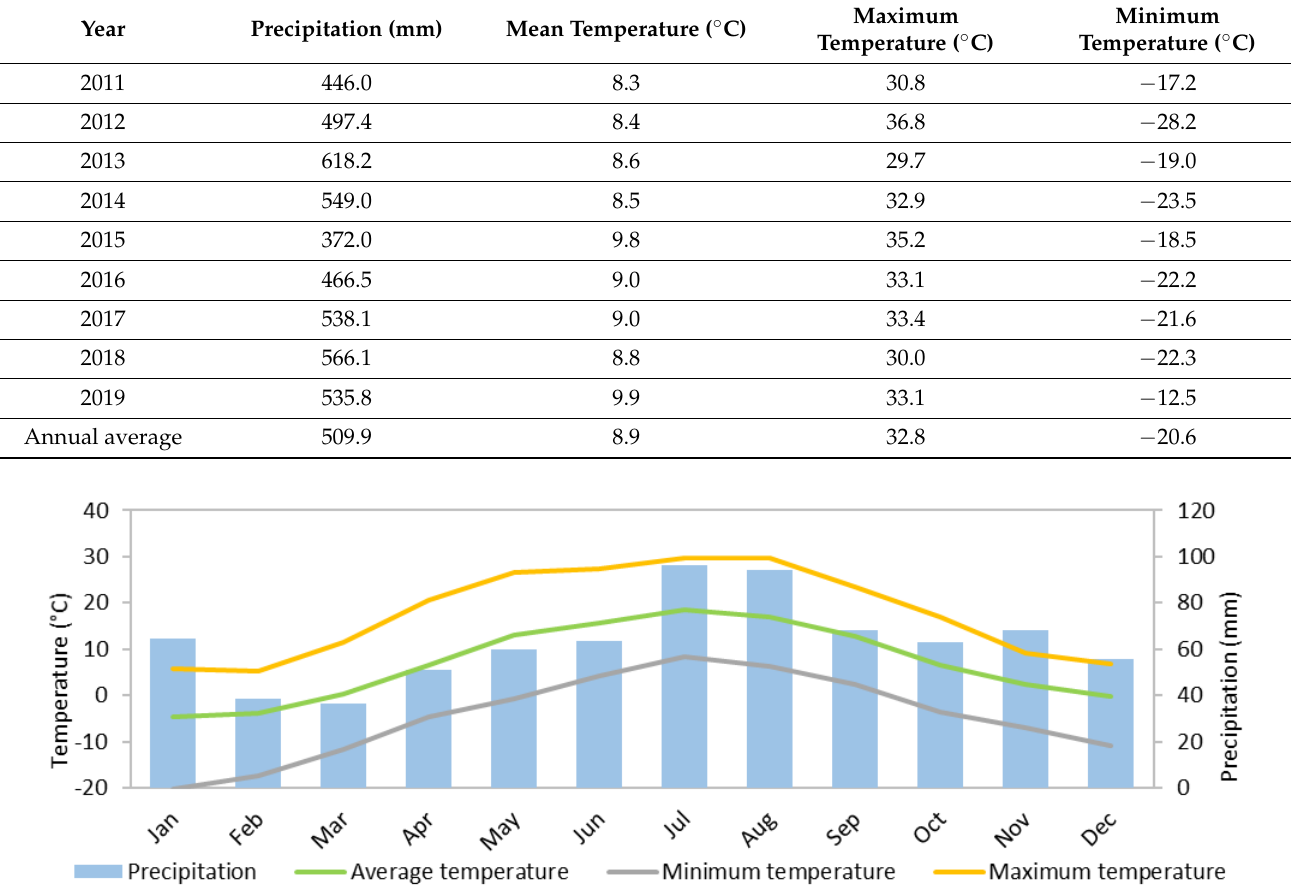
Table A3. Average climatic conditions of the study site located in Ukraine during the study period.